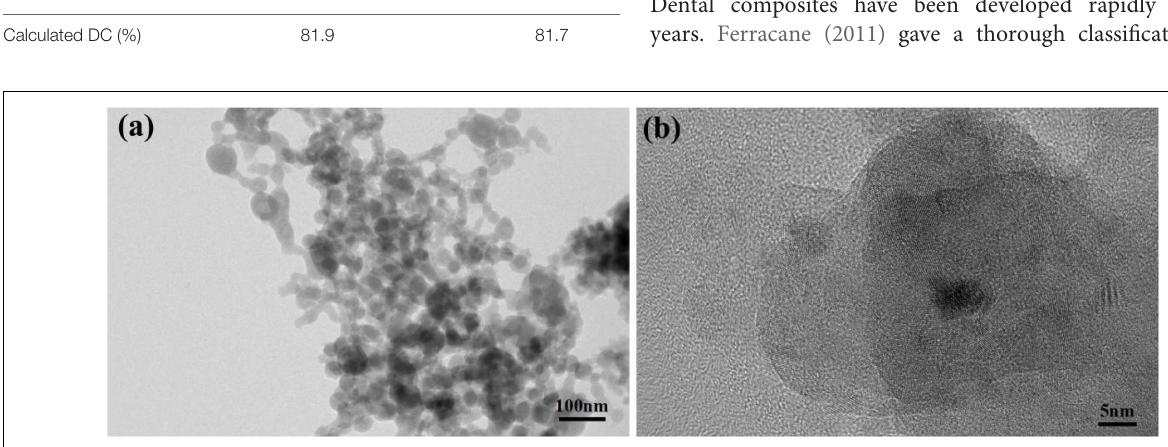
Frontiers in Materials |